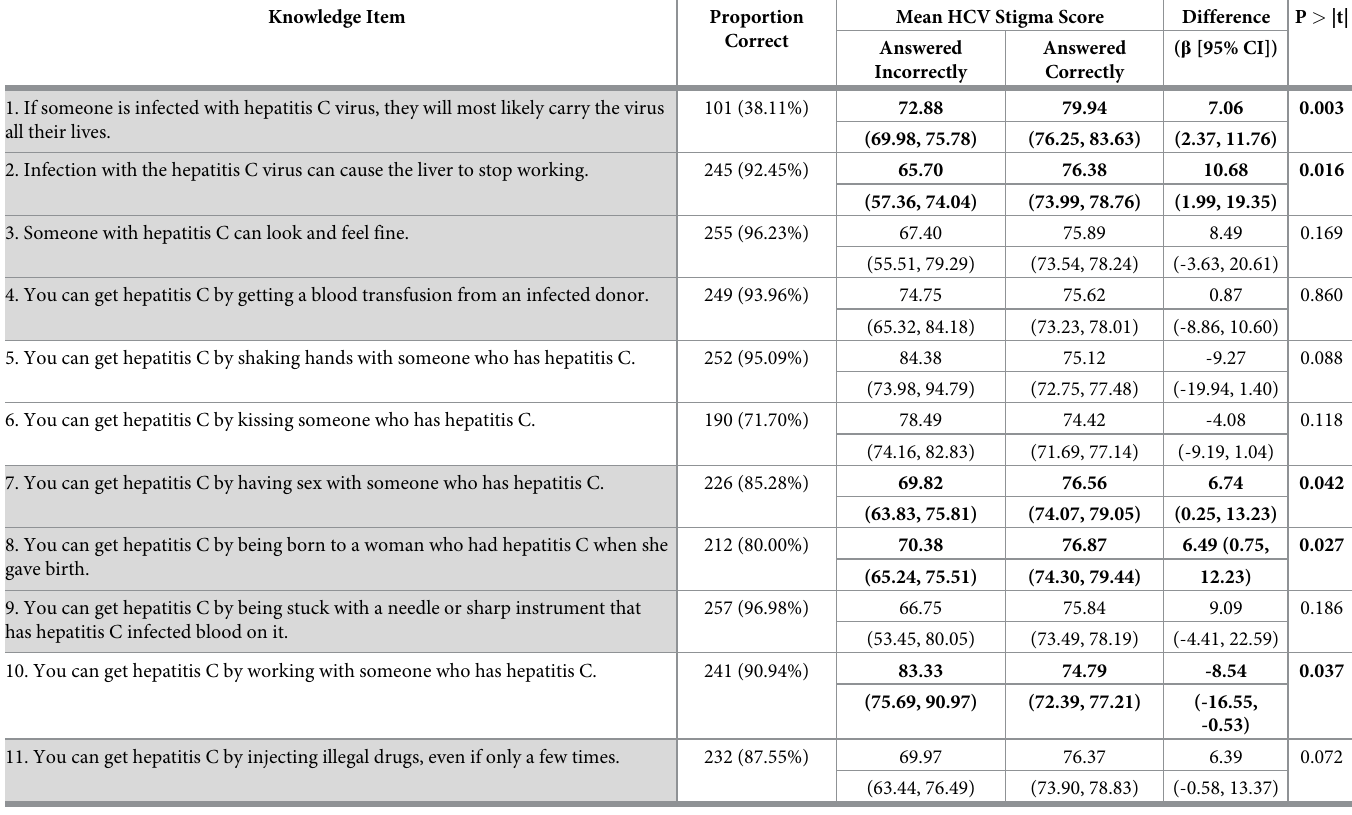
Table 3. Association between knowledge items about transmission and natural history of hepatitis C virus and hepatitis C-related